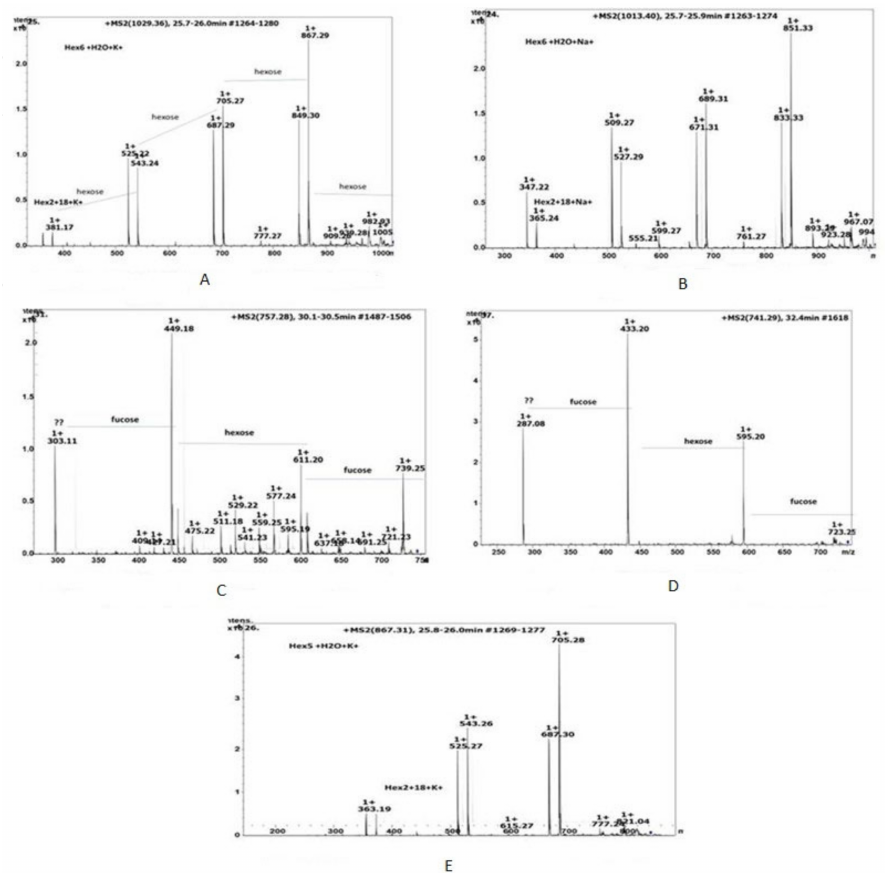
Figure 7. Mass Spectrum of Sugar-based molecules ( A ) SA1029.3 & ( B ) SA 1013.4 with hexose, ( C ) SA 757.2 & ( D ) SA 741.2 with fructose and hexose and ( E ) SA 887.31 with